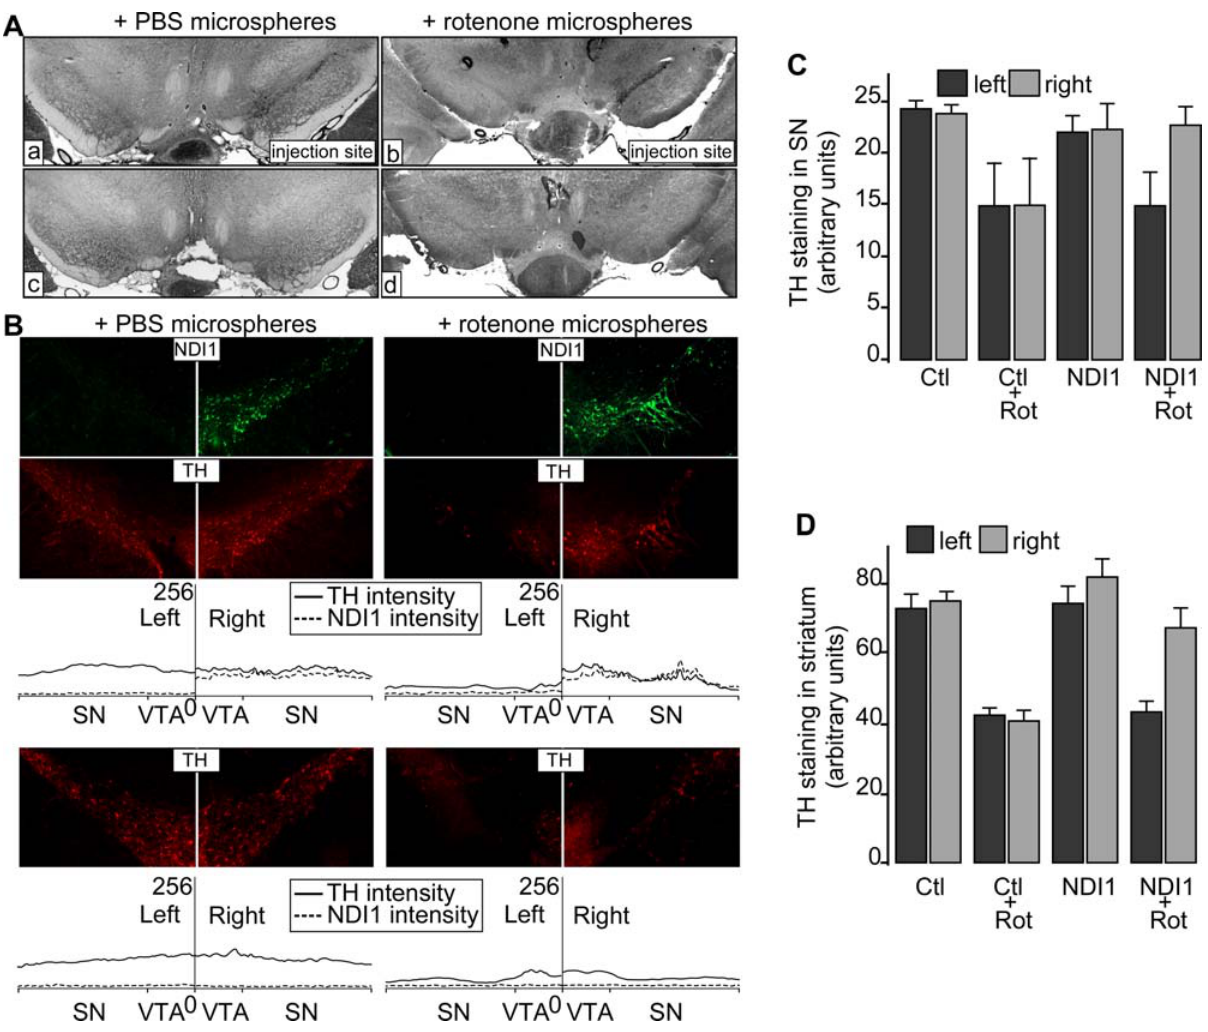
Figure 2. Expression of the Ndi1 protein in the rat SN and its effect on the TH levels in the SN and striatum after rotenone exposure. Rats received a unilateral injection of recombinant AAV carrying the NDI1 gene targeted at the right SN. Control rats were injected with PBS. After the expression of the Ndi1 protein has been established, microspheres containing rotenone were injected subcutaneously. For control, microspheres with PBS were used. Thirty or 60 days later, brains were collected for analysis. A: After 30 days of rotenone exposure, brain sections at the level of SN were stained for the NADH dehydrogenase (diaphorase) activity. The right SN that received the NDI1 gene showed high NADH dehydrogenase as revealed by dense staining in both rotenone-treated (b) and PBS-treated (a) group. Non-NDI1 control rats did not exhibit discernible staining (c and d). B: Brain sections from the same groups of rats as A were double-stained for TH (red) and the Ndi1 protein (green). The staining intensities across the right SN ( NDI1 injection side) and the left SN are plotted in arbitrary units below each set of the images. Each picture displays a representative section of an animal from each group. C: Rats expressing the Ndi1 protein (NDI1) and non-NDI1 control group (Ctl) were treated with rotenone (Rot) for 60 days and immunohistochemical staining for TH staining were carried out as in B. The fluorescence images of the brain sections were collected and the staining intensity of TH from the left and the right SN was statistically analyzed (student T-test) using ImageJ [39]. Note that the right SN received the NDI1 injection. The number of sections used was; Ctl (n=6), Ctl + Rot (n=9), NDI1 (n=18) and NDI1 + Rot (n=18). Images in each group were collected from evenly spaced sections that cover the entire SN in which the presence of the Ndi1 protein was detected. Error bars represent standard deviation. D: Levels of TH staining in the left and right striatum from the same four groups of rats as in C are compared. The right striatum is ipsilateral to the SN expressing the Ndi1 protein. Representative images of DAB staining of TH are given in Figure S2. The number of sections used for analysis was; Ctl (n=6), Ctl + Rot (n=9), NDI1 (n=9) and NDI1 + Rot (n=18). Error bars represent standard deviation. the total number of such inclusions was too small to obtain statistically reliable data. Neuronal cell death is another key observation in the rotenone rat model of PD. Approximately 50% of the SN neurons died in our rotenone model (Figure 3A). Comparison of the number of SN neurons between the injection side and the opposite side clearly showed that the Ndi1 protein expression prevented neuronal cell death in rotenone-treated animals. The preferential death of the nigrostriatal neurons under rotenone exposure may result from the synergic effect of ROS modifications in the SN neurons. Again, the data from the Ndi1-